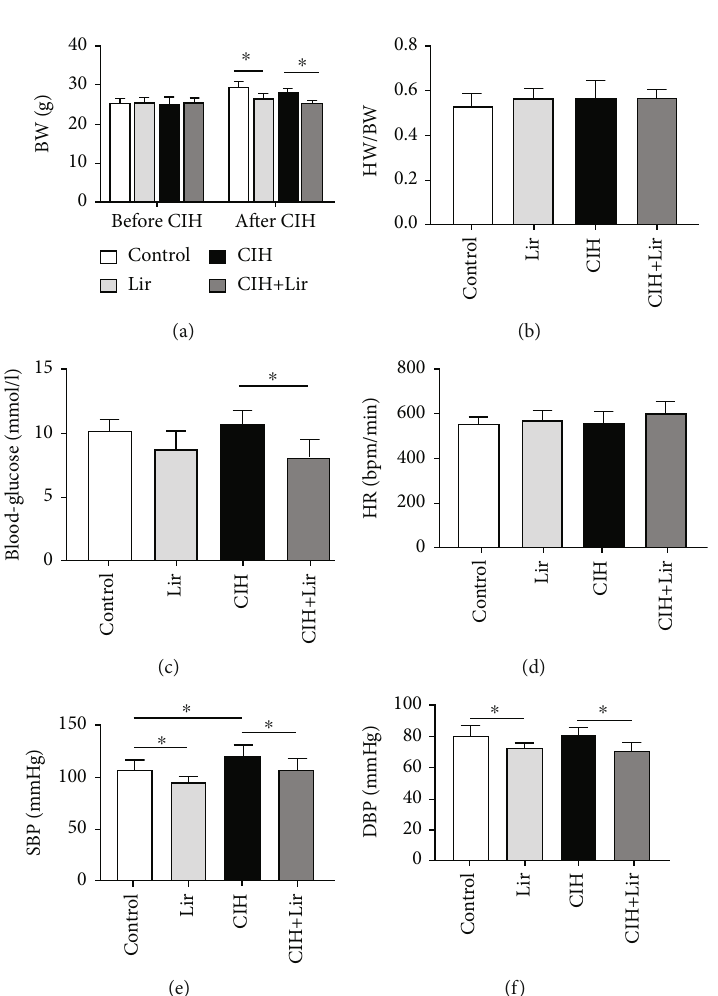
Figure 1: The e ff ect of Lir on body weight, HW/BW, blood glucose, blood pressure, and heart rate. (a, b) Statistical results of the BW, HW/ BW ratios ( n = 8 ) after CIH and/or Lir treatment. BW was decreased following Lir administration. (c) The e ff ect of Lir on blood glucose ( n = 8 ), the blood glucose was decreased in the CIH+Lir group compared with the CIH group. (d – f) Heart rate and pressure measurements of systolic (SBP) and diastolic blood pressure (DBP) in di ff erent groups ( n = 8 ). Both SBP and DBP were decreased with no change in HR following Lir administration. Data are mean ± SEM , ∗ P < 0 : 05